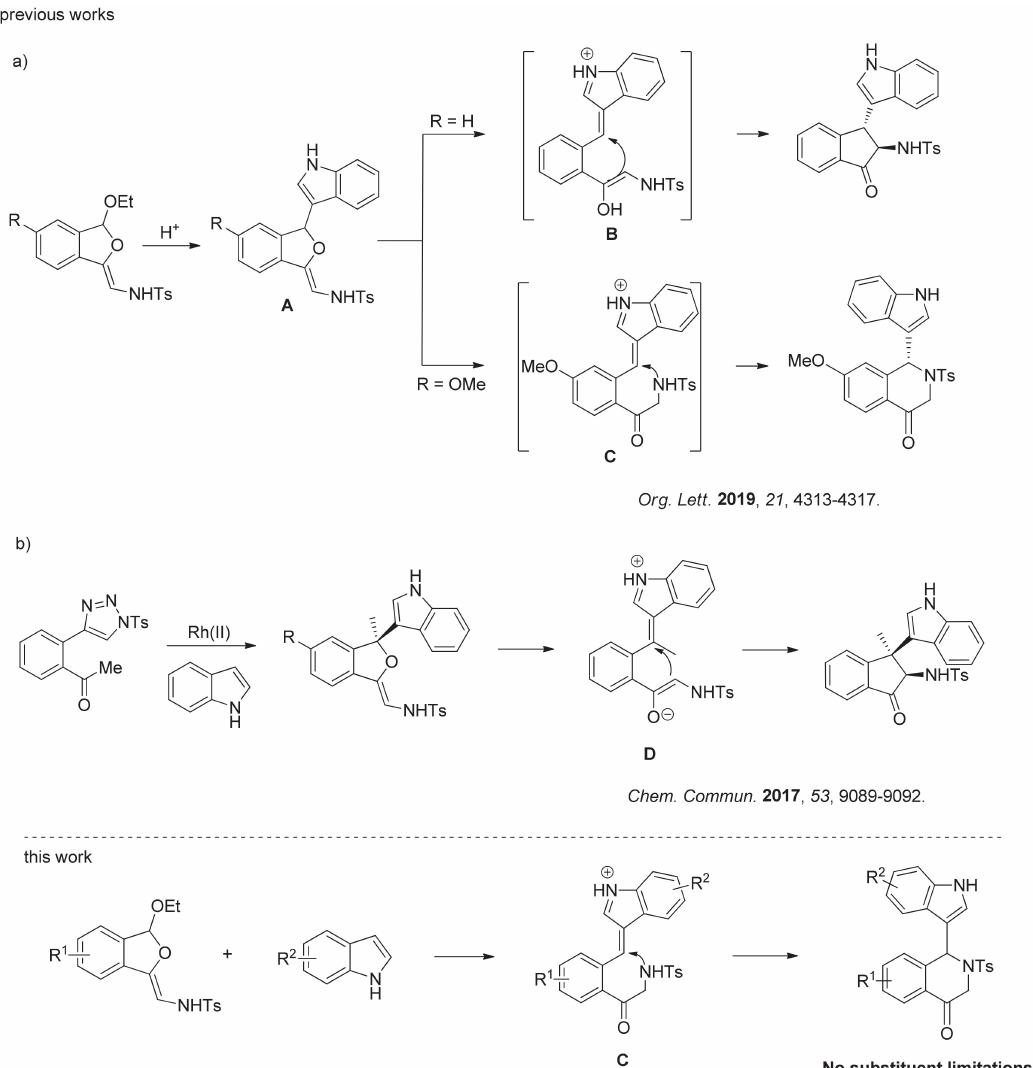
Figure 2. Related Research and This Work. ( a ) Switchable Skeletal Rearrangement of Dihydroiso- benzofuran Acetals with Indoles. ( b ) Rhodium-catalyzed tandem reaction of N -sulfonyl triazoles with